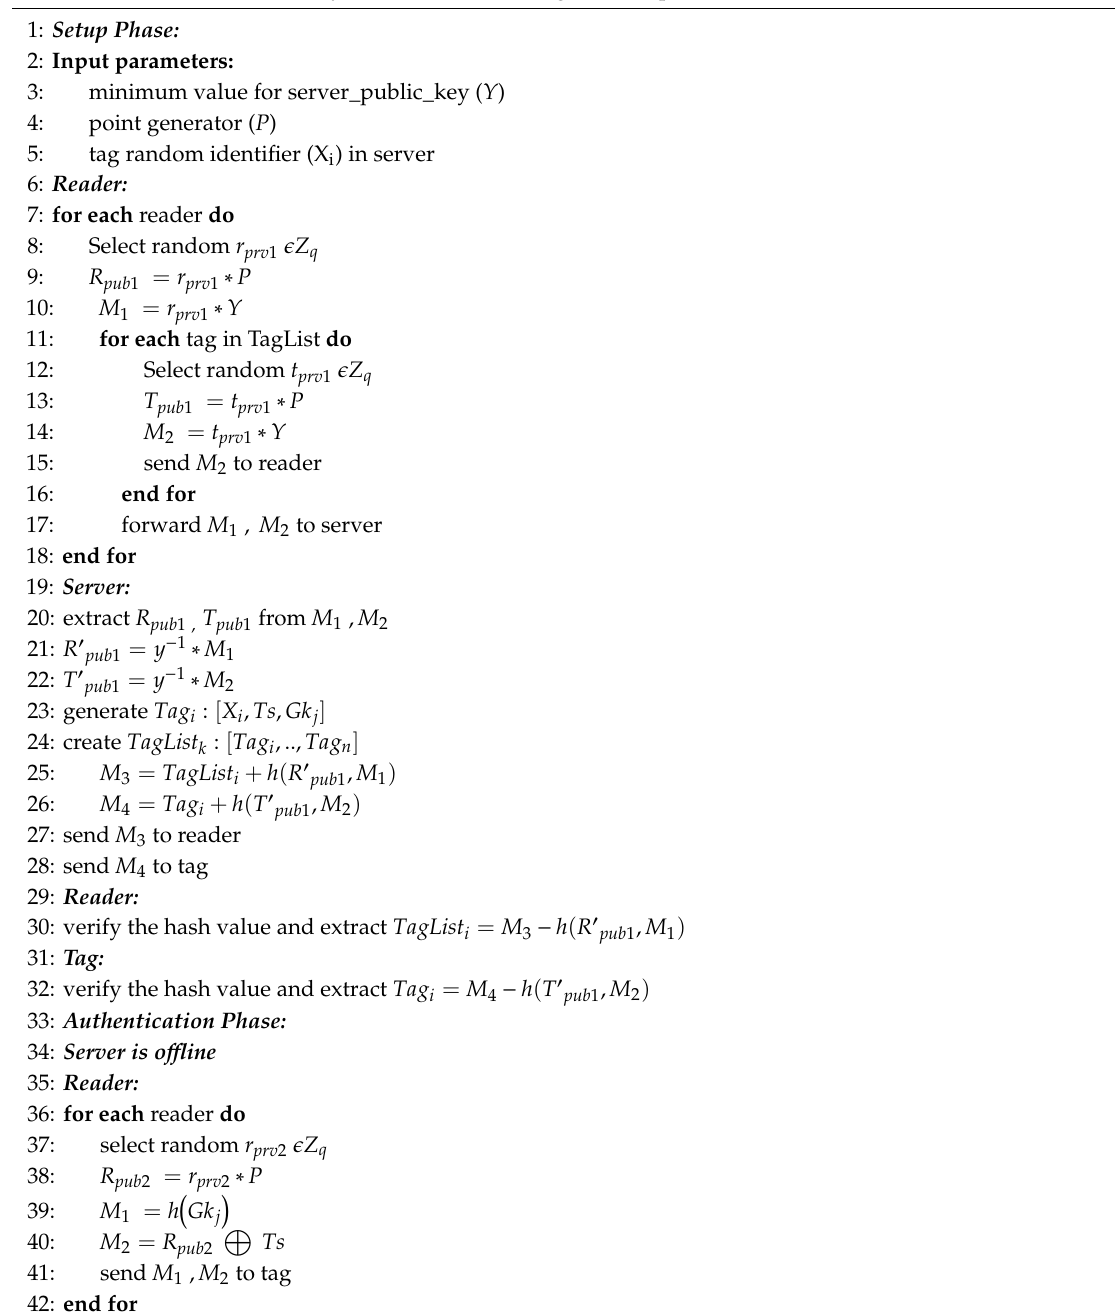
Algorithm 1 SLEC (executed by server, reader, and tag in SLEC